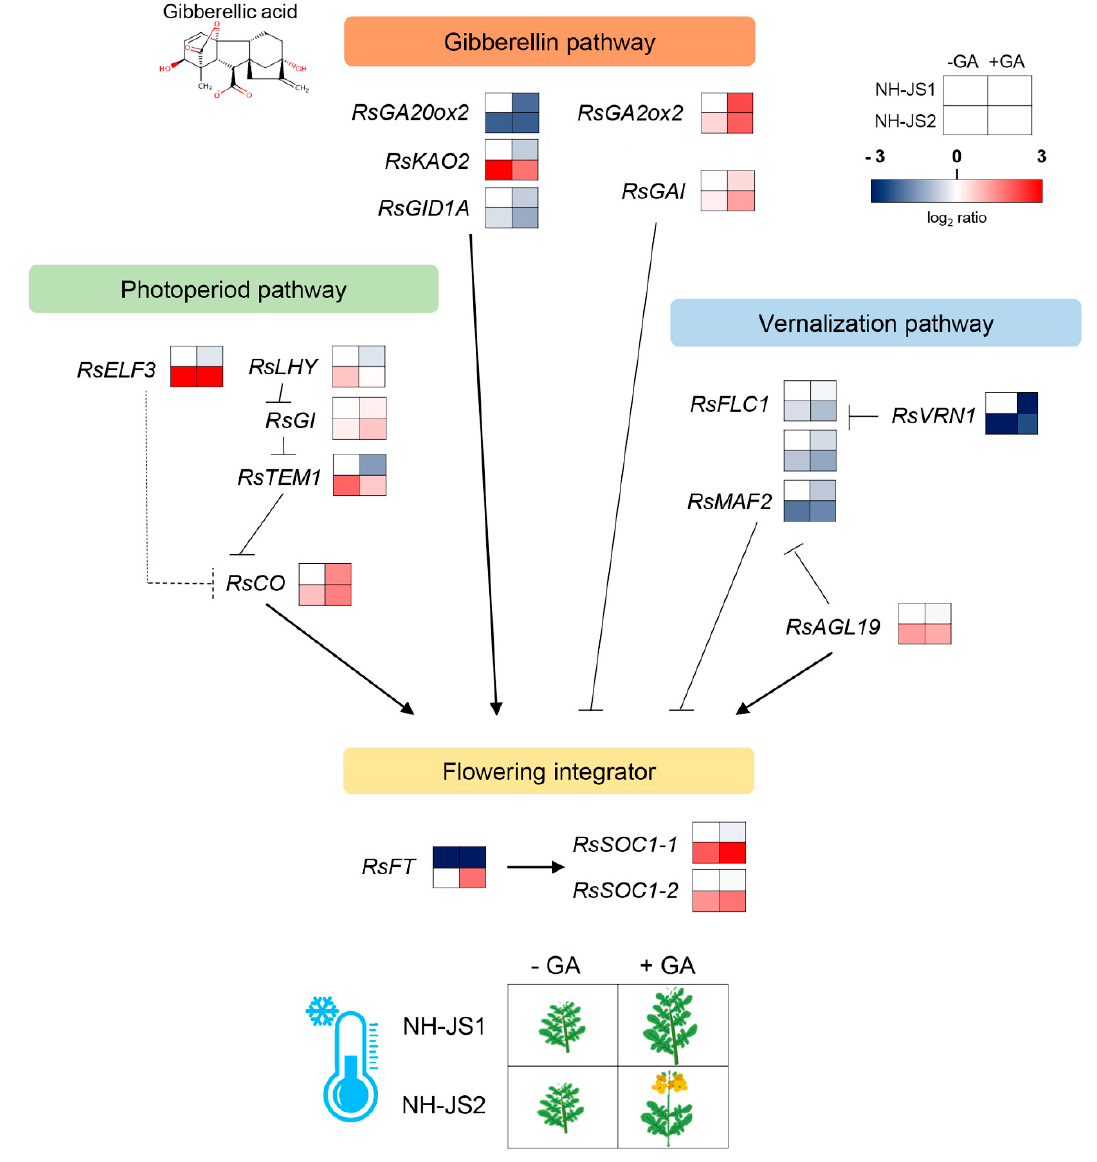
Figure 6. Gene regulatory network controlling gibberellin-accelerated flowering in radish. The illustration maps the regulatory network of flowering time genes in NH-JS1 (late-bolting) and NH-JS2 (early-bolting) plants treated with GA. The network is based on data confirmed by qPCR. Gene expression levels were normalized relative to the expression levels in non-GA-treated NH-JS1 plants (for RsFT , non-GA-treated NH-JS2 plant data analysis included log 2 ratio.). Red indicates higher expression levels and blue indicates lower expression levels relative to non-GA-treated NH-JS1 ( RsFT expression is relative to non-GA-treated NH-JS2). Arrows indicate transcriptional activation; bars indicate transcriptional repression.